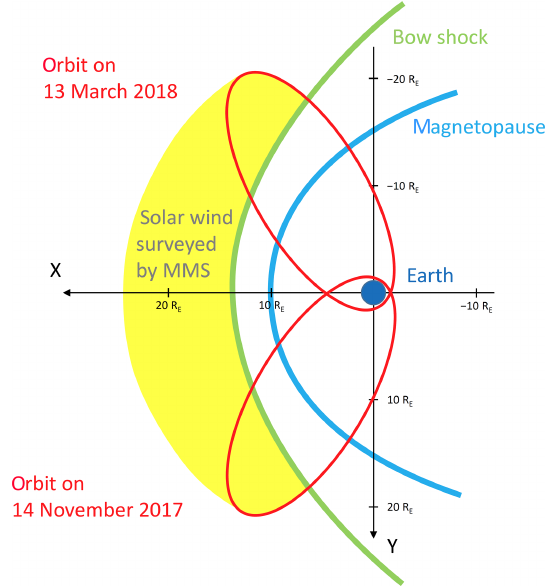
Figure 1. Sketch of the MMS extended mission phase 3B orbits between 14 November 2017 and 13 March 2018. Locations where MMS surveyed the solar wind in that phase are displayed in yellow. The Sun is to the